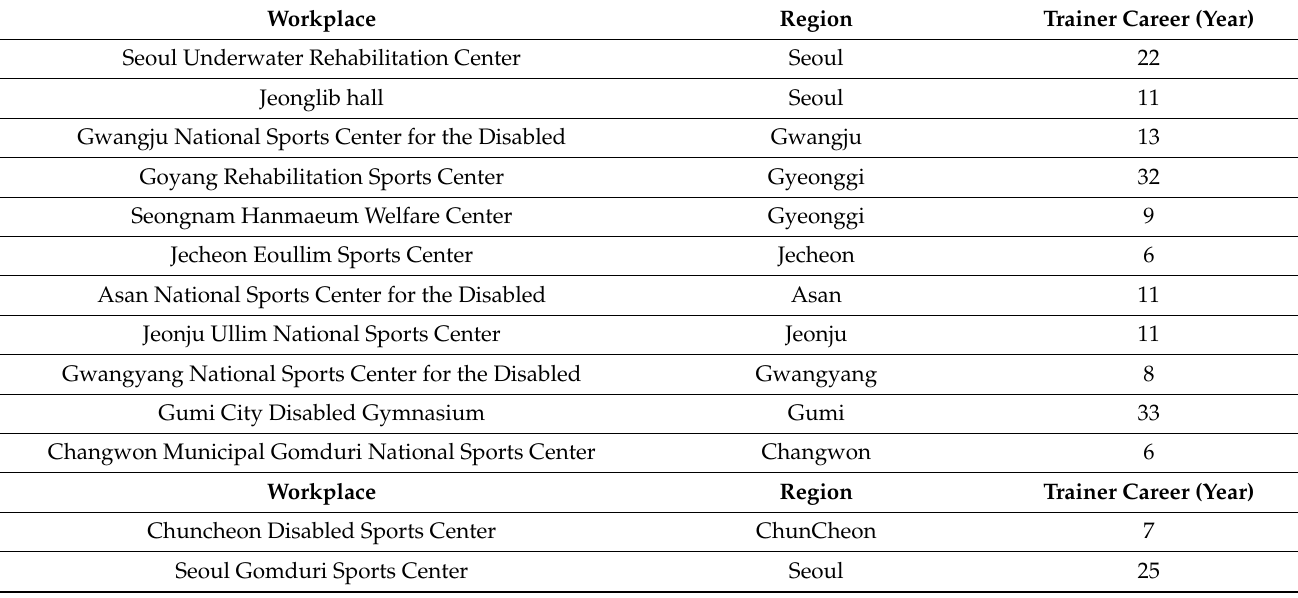
Table 1. Focus group interview